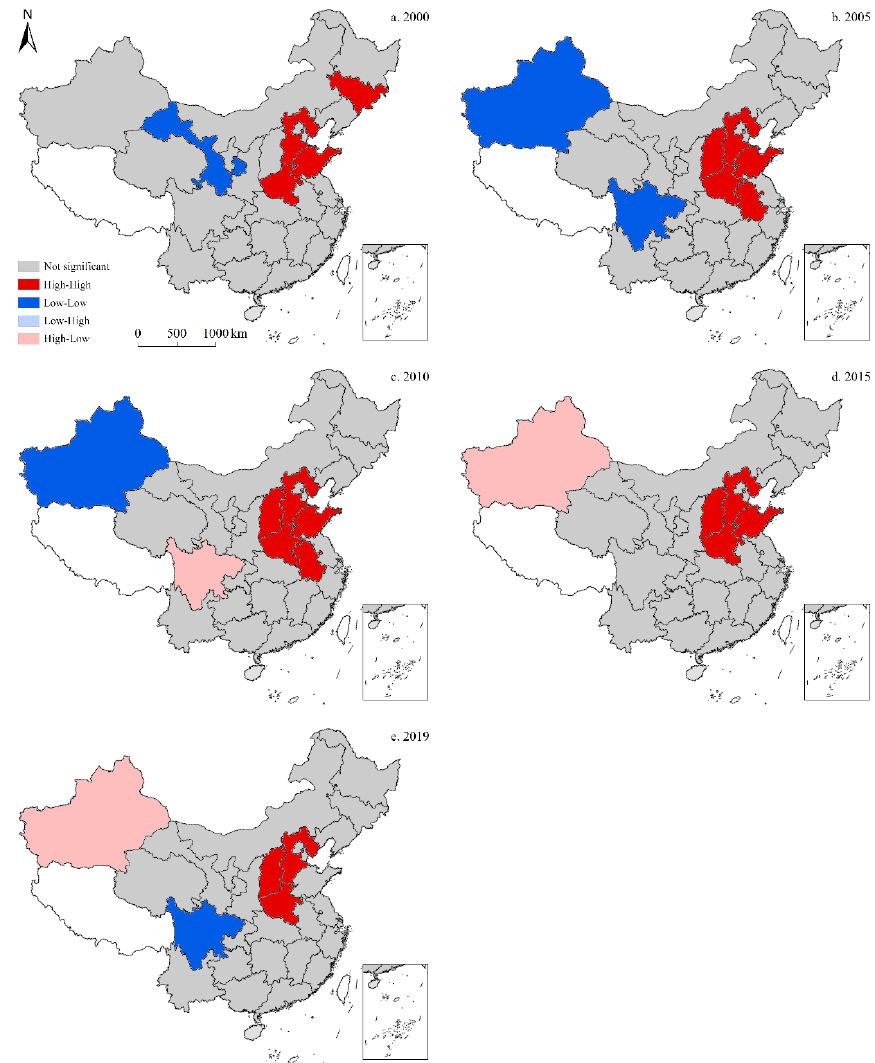
Figure 10. Local indicators of spatial association (LISA) map for the provincial-level spatiotemporal distribution of total CO 2 emissions in China (five-time sections).